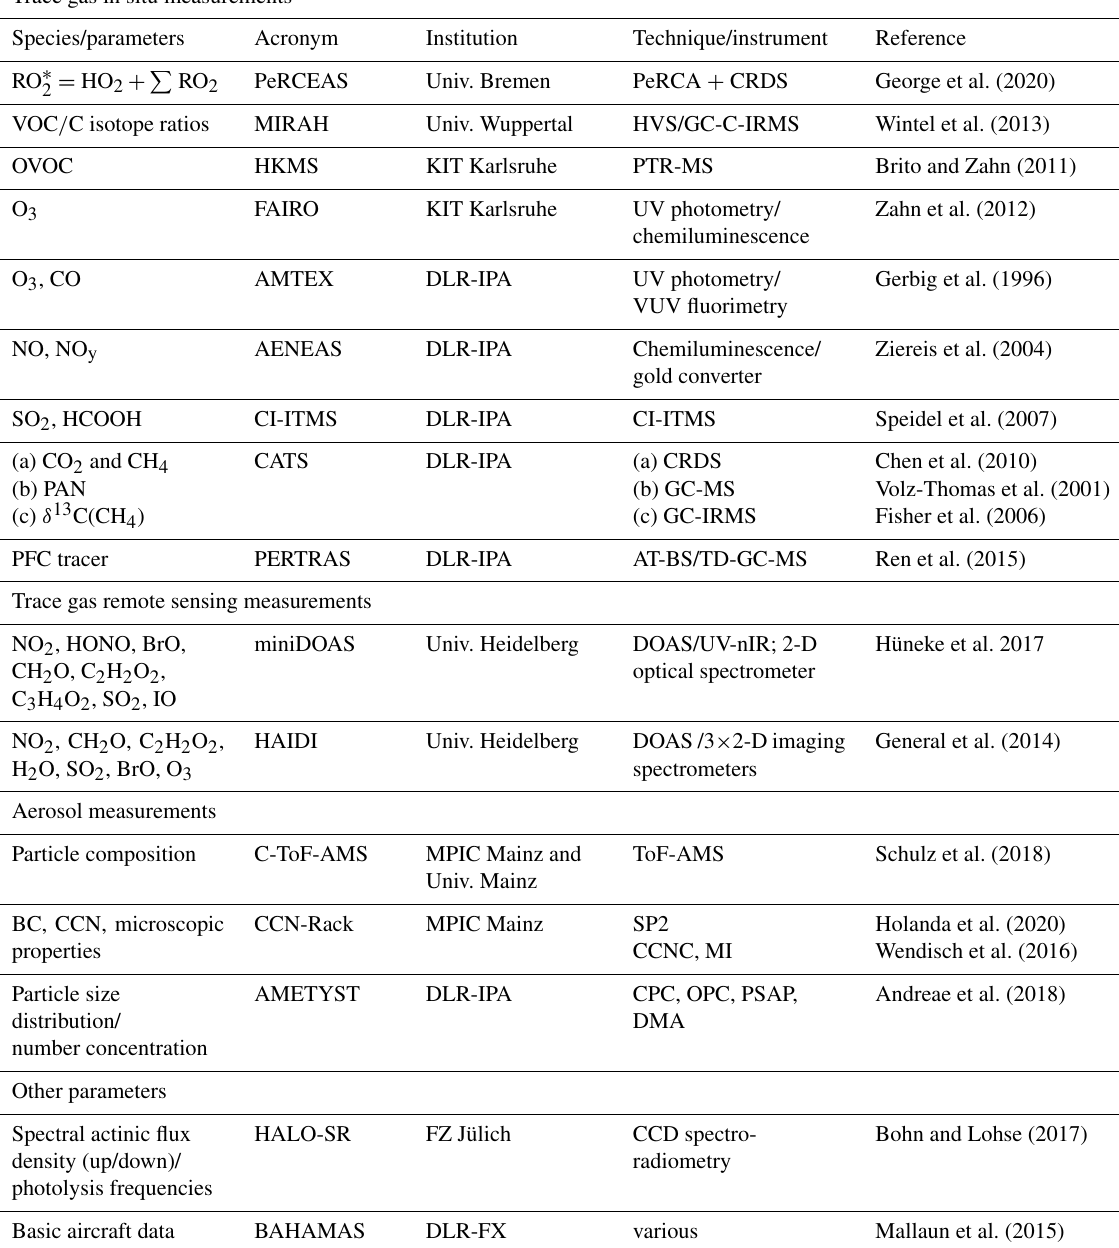
Table 2. HALO instrumental payload for EMeRGe: PeRCA: peroxy radical chemical amplification; CRDS: cavity ring-down spectroscopy; HVS: High-Volume Sampler; GC-C-IRMS: gas chromatography combustion isotope ratio mass spectrometry; PTR-MS: Proton-Transfer- Reaction Mass Spectrometer; CI-ITMS: chemical ionisation ion trap mass spectrometry; GC-MS: gas chromatography–mass spectrometry analysis; PAN: peroxyacetyl nitrate; δ 13 C(CH 4 ): isotopic signature of methane; PFC: perfluorinated carbon compounds; DOAS: differen- tial optical absorption spectrometry; AT-BS: adsorption tube and bag air sampler; TD-GC-MS: thermal desorption gas chromatography and mass spectrometry; ToF-AMS: time-of-flight aerosol mass spectrometry; SP2: Single-Particle Soot Photometer; CCNC: Cloud Condensa- tion Nuclei Counter; MI: Multi-Impactor for aerosol offline analysis; CPC: Condensation Particle Counter; DMA: Differential Mobility Analyzer; OPC: Optical Particle Counter; PSAP: Particle Soot Absorption Photometer. See details and HALO ancillary measurements in